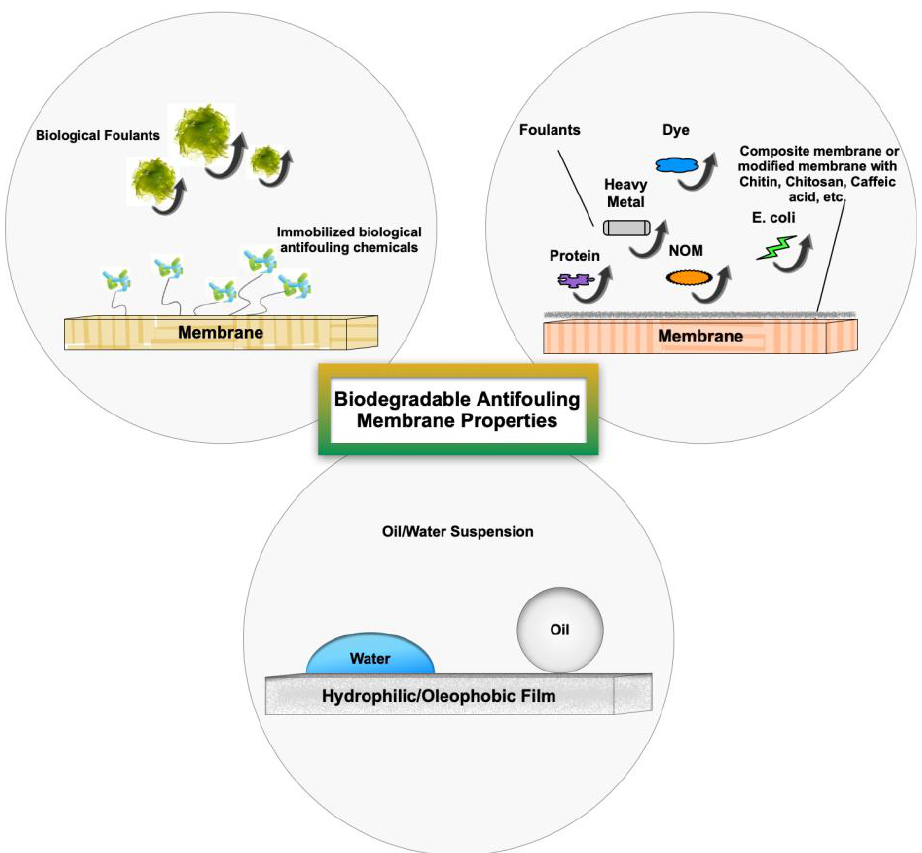
Figure 10. Schematic of membrane s’ antifouling properties.